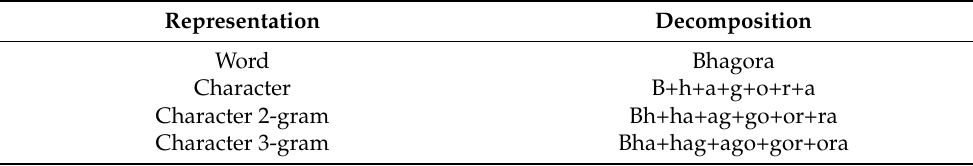
Table 4. Word and subword decomposition example of word “Bhagora”. Representation Decomposition